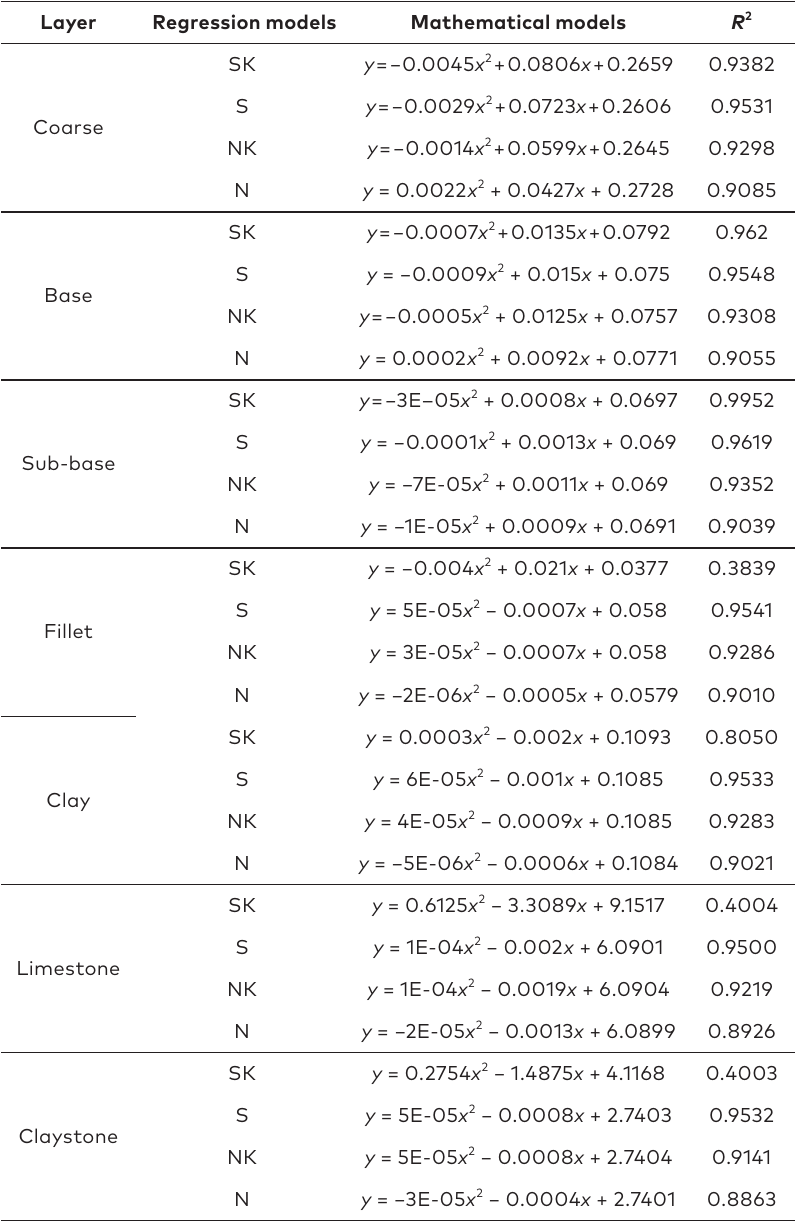
Table 11. Function and regression analyses of the relationship between the superstructure and soil layers of the road with Von Mises Time Layer Regression